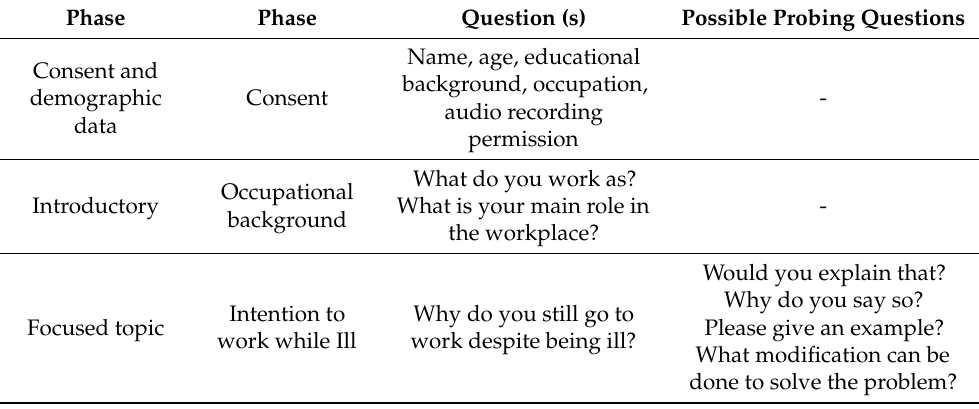
Table 1. Interview guide to be used in data